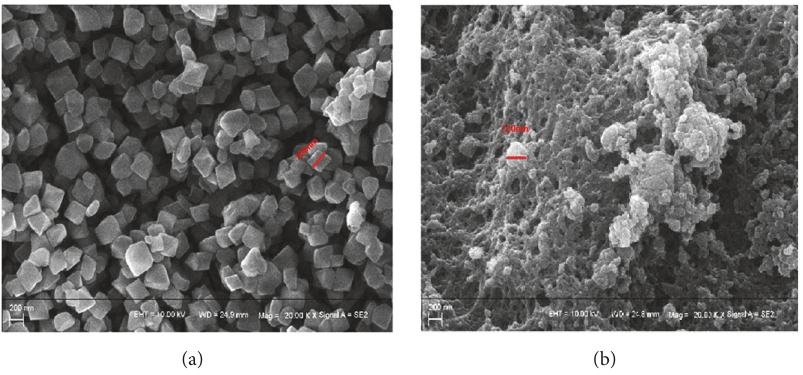
Figure 4: SEM images of MIL-101 (a) and MIL@MIP (b).